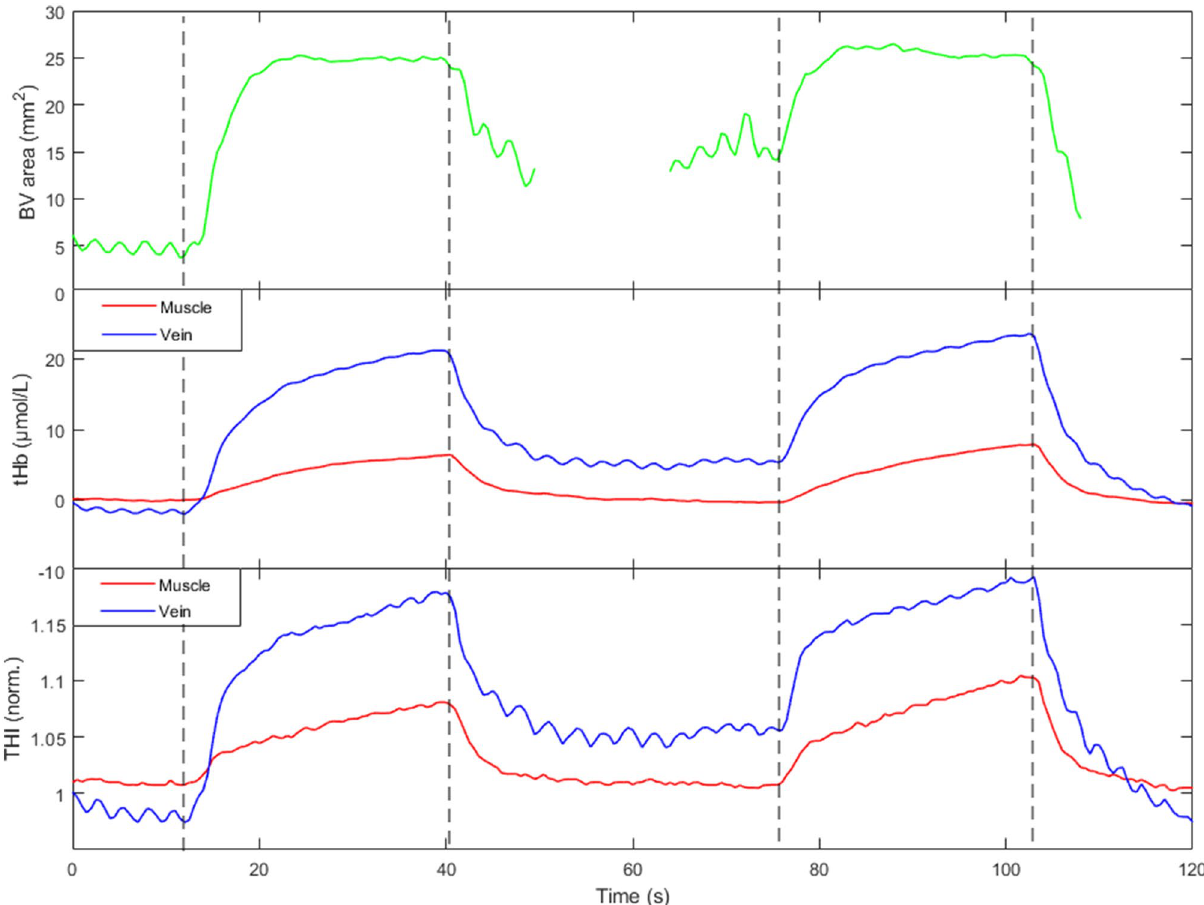
Figure 6. Original traces from a single subject showing the responses to two subsequent short lasting occluding stimuli (both at 40 mmHg). From top to bottom: cross-sectional area of the basilic vein (green), THI, and tHb signals collected from the vein (blue) and from the muscle (red). Note the presence of an oscillatory component of respiratory origin, synchronously appearing on the vessel cross-sectional area and on the venous NIRS signals only. Vertical dashed lines indicate start of cuff inflation and deflation.